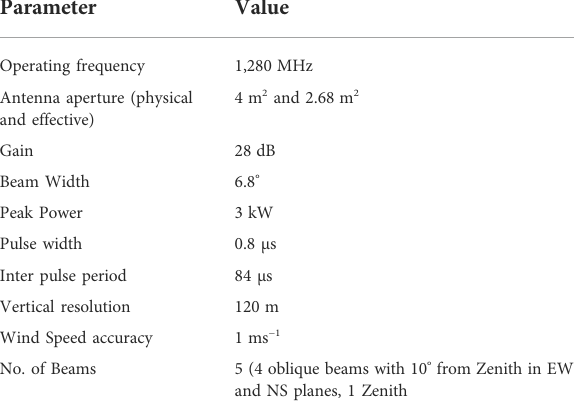
TABLE 1 Speci fi cations of the wind pro fi ler radar.